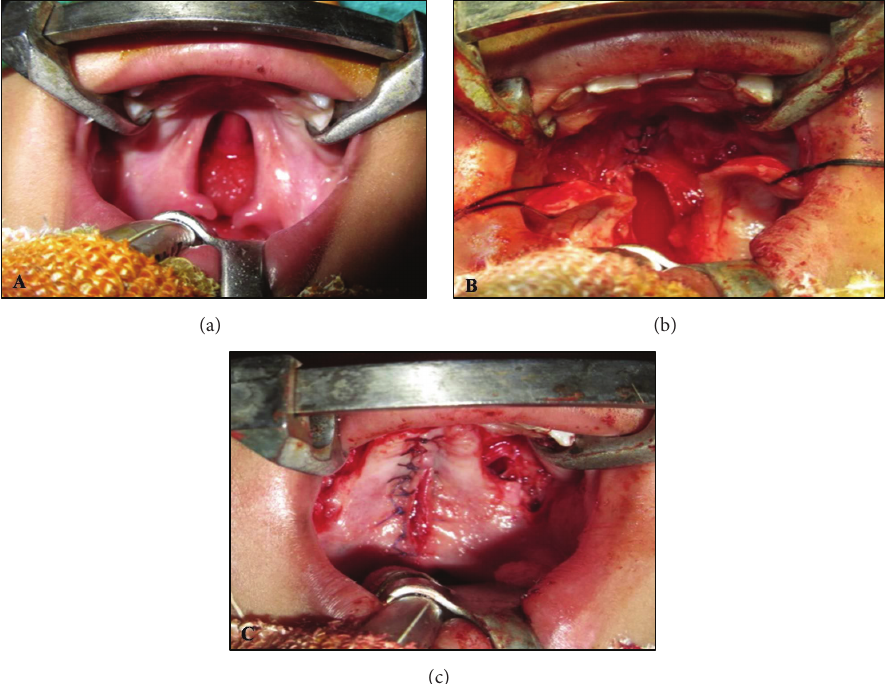
Figure 2: Veau-Wardil-Killner palatoplasty. (a) Preoperative photograph showing bilateral incomplete cleft palate. (b) Photograph showing elevated flaps bilaterally based on greater palatine arteries. Palatal mucosa in nasopalatine region is kept undisturbed. (c) Photograph showing closure of cleft palate.